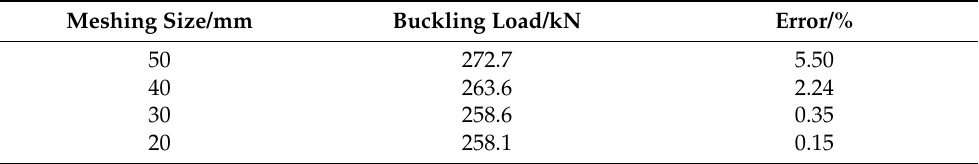
Table 1. Buckling loads and errors were calculated from the mesh of different sizes.